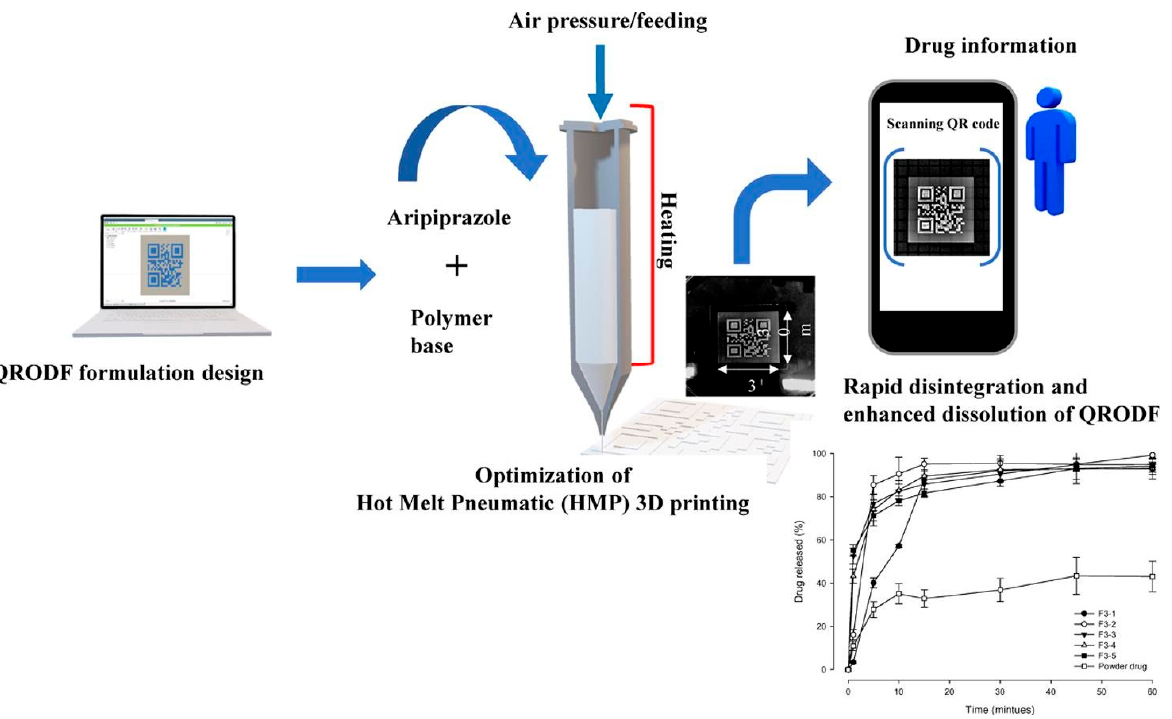
Figure 3. Scheme of ODF design for QR reading and rapid disintegration and enhanced dissolution [61]. This article was published in International Journal of Pharmaceutics, Vol 584, Byung-Cheol Oh, Gang Jin, Chulhun Park, Jun-Bom Park, Beom-Jin Lee, Preparation and evaluation of identifiable quick response (QR)-coded orodispersible films using 3D printer with directly feeding nozzle, 119405, Copyright Elsevier, 2020.